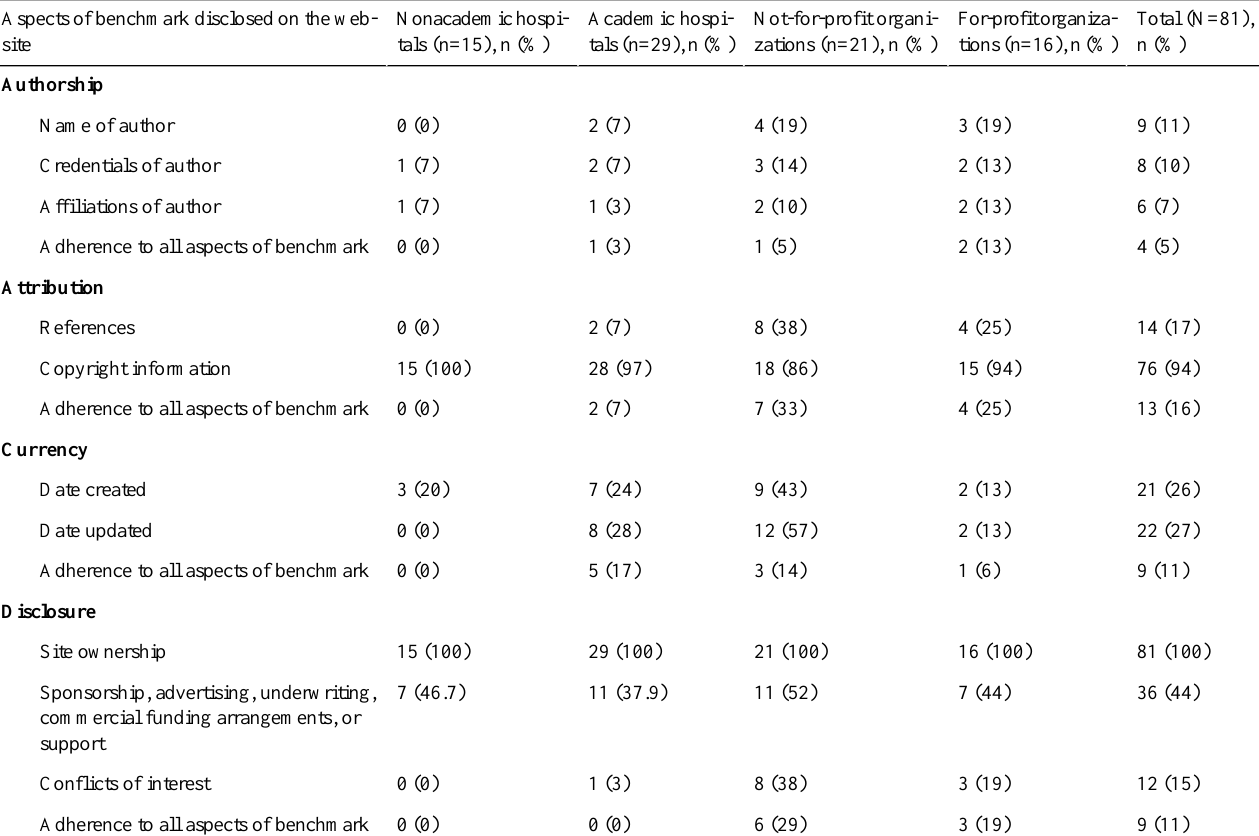
Table 2. Performance of websites on subdivisions of Journal of the American Medical Association benchmarks per category.